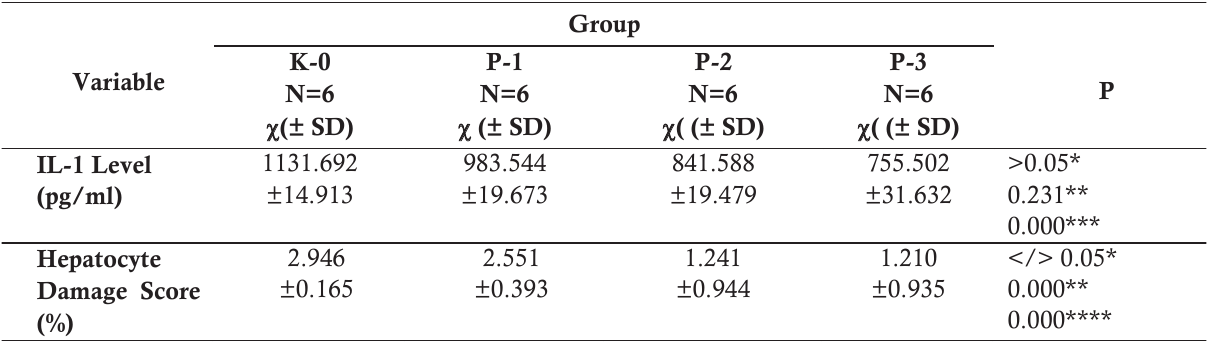
Table 1. Result of statistical analysis on the measurement of IL-1 level and Hepatocyte Histopathology Score